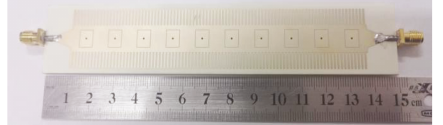
Figure 4: Photograph of the fabricated CSIW-CRLH LWA.